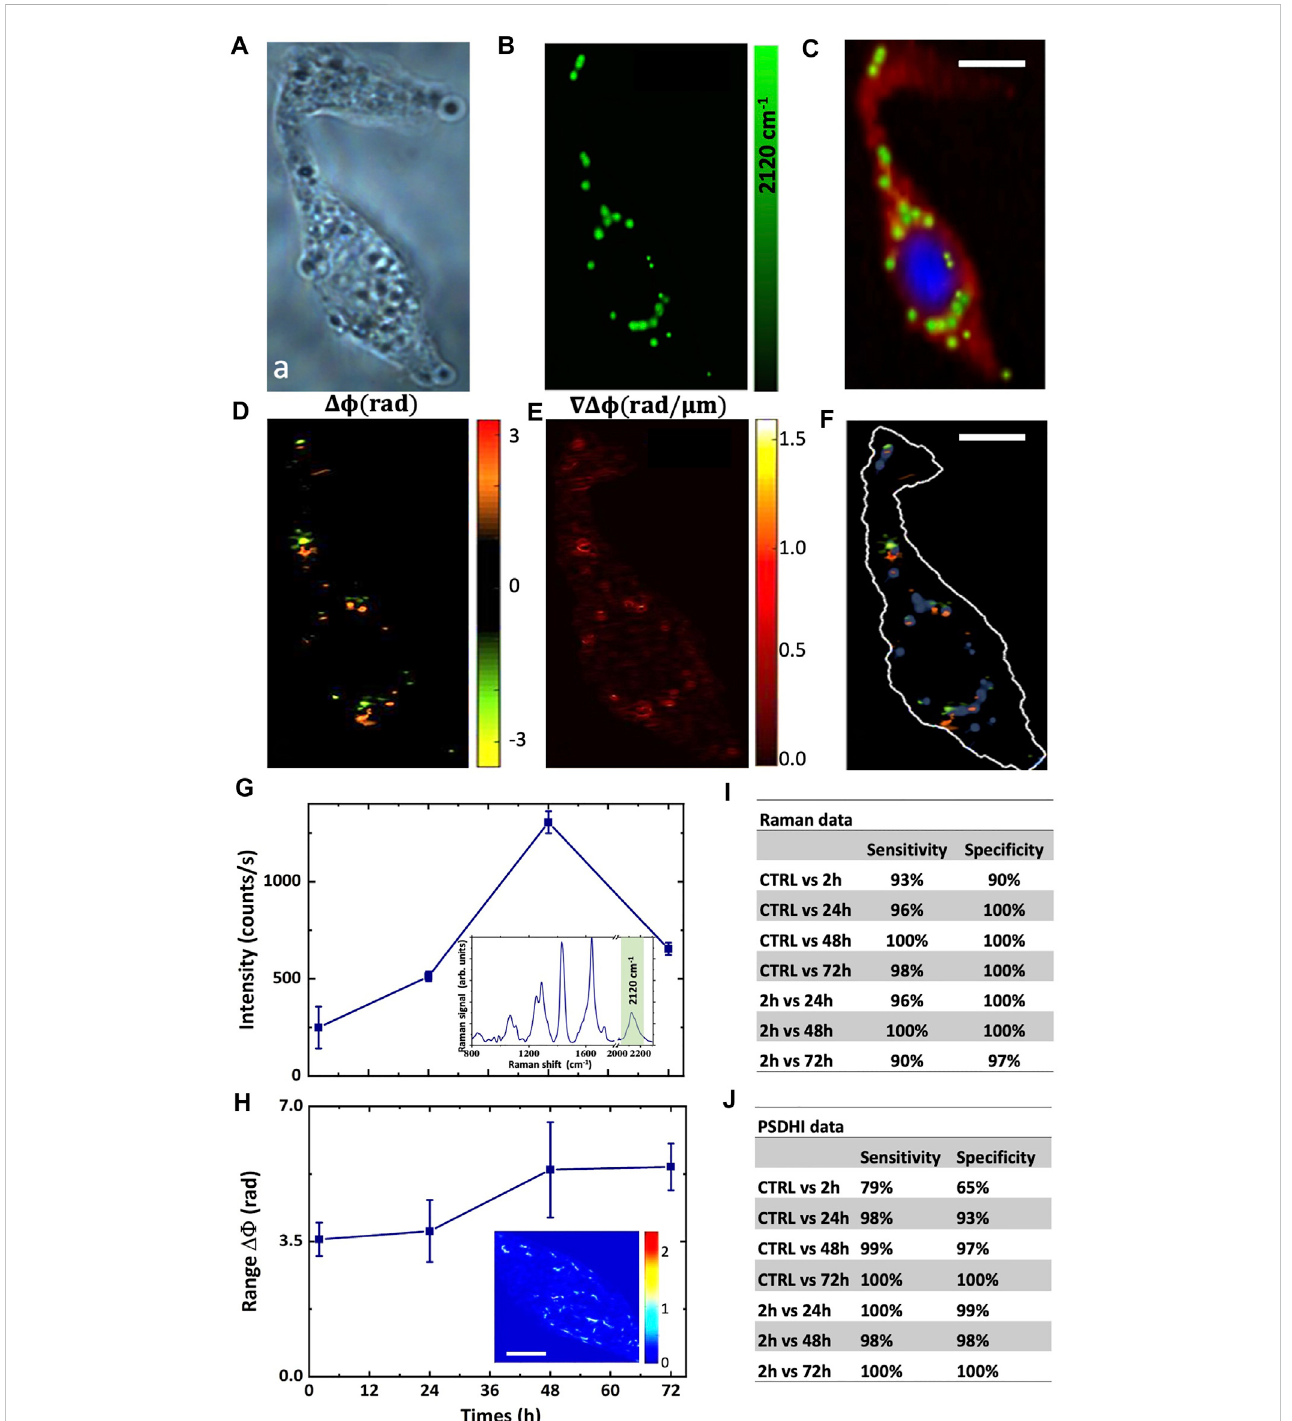
FIGURE 2 Imaging of the HepG2 cell and D-glucose uptake dynamics. (A) Bright fi eld image of the HepG2 cell. (B) Raman map of the C-D band signal, and (C) reconstructed false colour Raman image using the DNA Raman bands at 2,956 cm − 1 and 785 cm − 1 for the nucleus (blue signal), the protein bands at 2,930 cm − 1 and 1,100 cm − 1 for the cytosol (red signal) and C-D bands at 2,120 cm − 1 for the lipid droplets (green signal). The exposure time for each pixel was 1 s. (D) Phase difference; and (E) the corresponding phase difference gradient maps retrieved by PSDHI. (F) Merged image of the Raman map of the C-D bandsignalsandthephasedifferencemapbyPSDHImaps,assessingtheco-localizationoftheC-DsignalofthelipiddropletsandtheSoPvariation.Scalebar: 10 μ m (G) ThegraphshowsthedeuteriumpeakintensityinHepG2cellstreatedwith25 mMdeut-Glcfor2,12,24,48and72 h.Dataareshowedasmean±SD of three independent experiments. Insert shows the mean Raman spectrum of LDs in HepG2 cells treated with 25 mM deut-Glc for 48 h. (H) Range of phase differenceinradiantforHepG2celllinetreatedwith25 mMdeut-Glcfor2,24,48and72 h.Dataareshowedasmean±SDofthreeindependentexperiments. In the inset, the phase difference gradient is reported. Scale bar is 5 μ m. Sensitivity and Speci fi city obtained from PCA for Raman data set (I) and PSDHI data set (J)